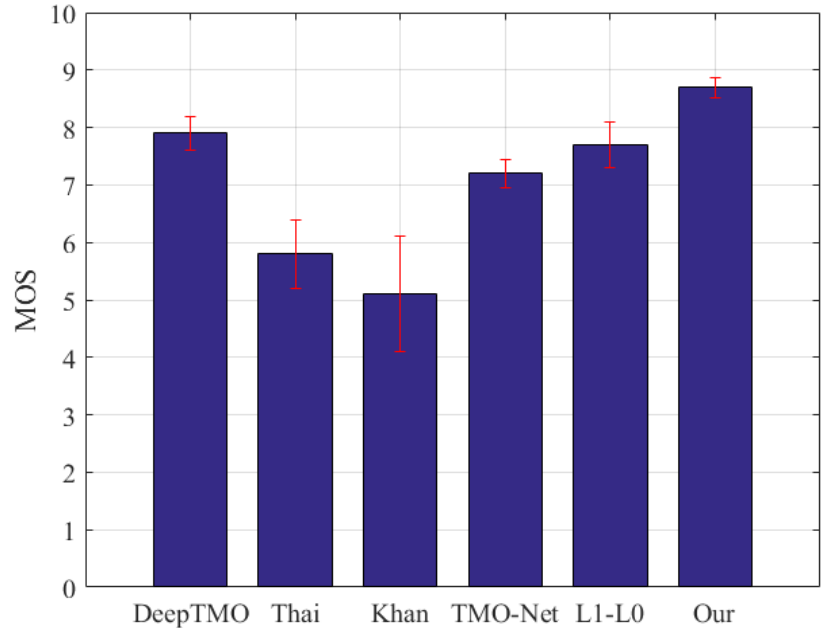
Figure 12. Mean and std of subjective rankings of the six tone mapping algorithms.